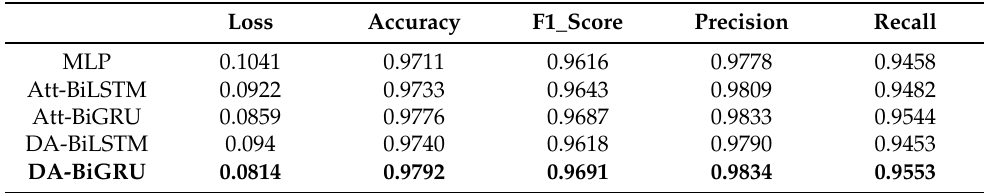
Figure 13. Comparison of experimental results of different methods. The experimental results of different models on the test set are shown in Table 5. Table 5. Comparison of results of different models on test